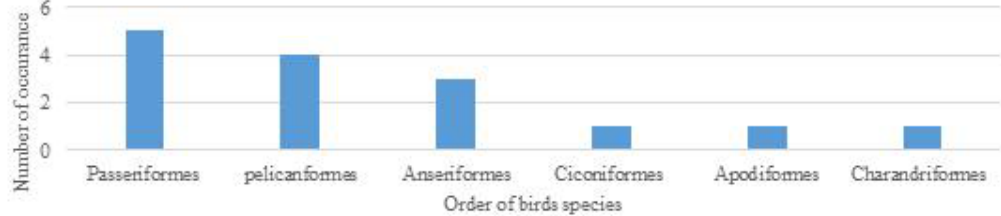
Fig. 2: The order wise number of families on dumpsite and sewage stabilization pond